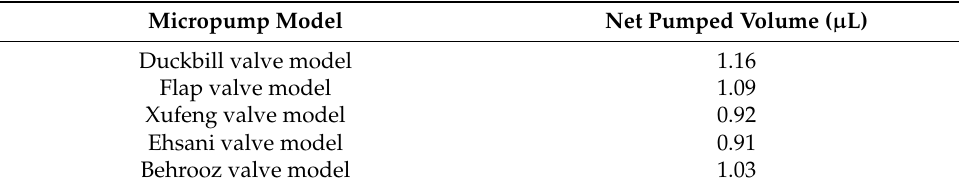
Figure 14. Comparison of net volume pumped. Table 7. Net pumped volume of micropumps.